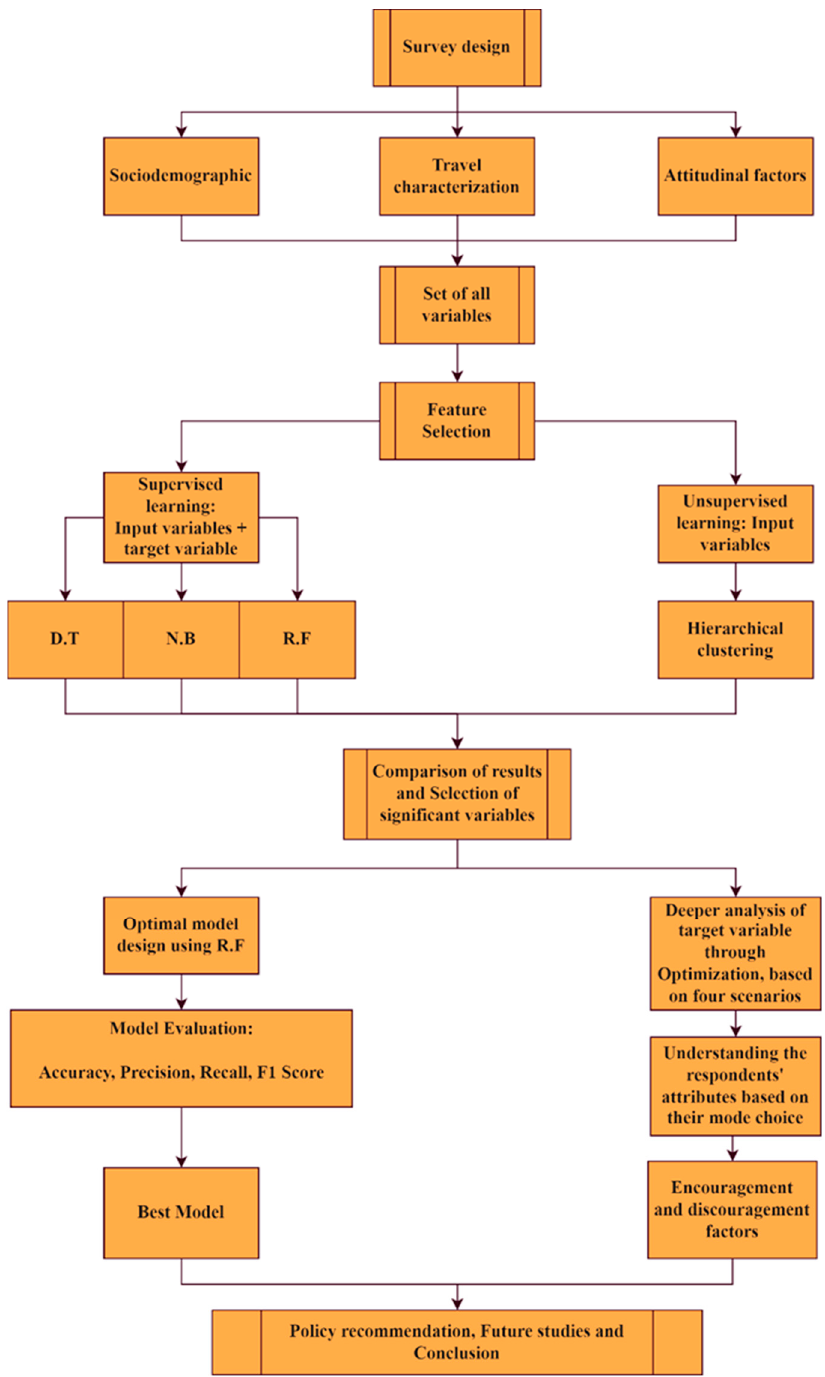
Figure 2. Methodology workflow.